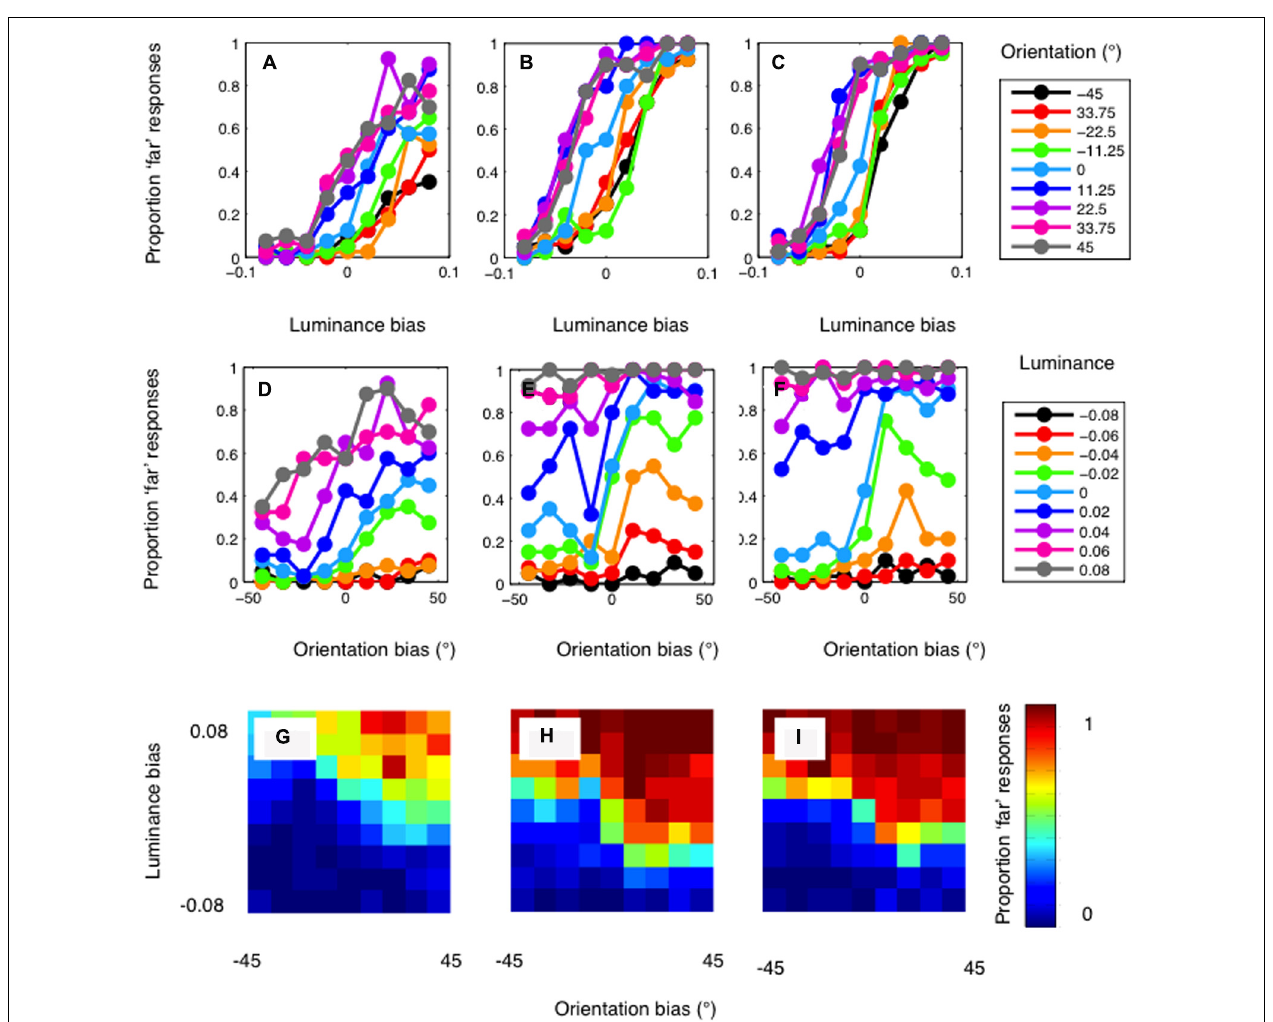
of orientation bias.When matching is not biased by luminance similarity (the cyan curve) a clear effect of orientation is evident for all three observers.With a large luminance matching bias, orientation has little or no effect on disparity matching. (G–I) plot the psychophysical data as a heat-map to illustrate the full two-dimensional psychometric function.The color of the pixels indicates the proportion of “far”